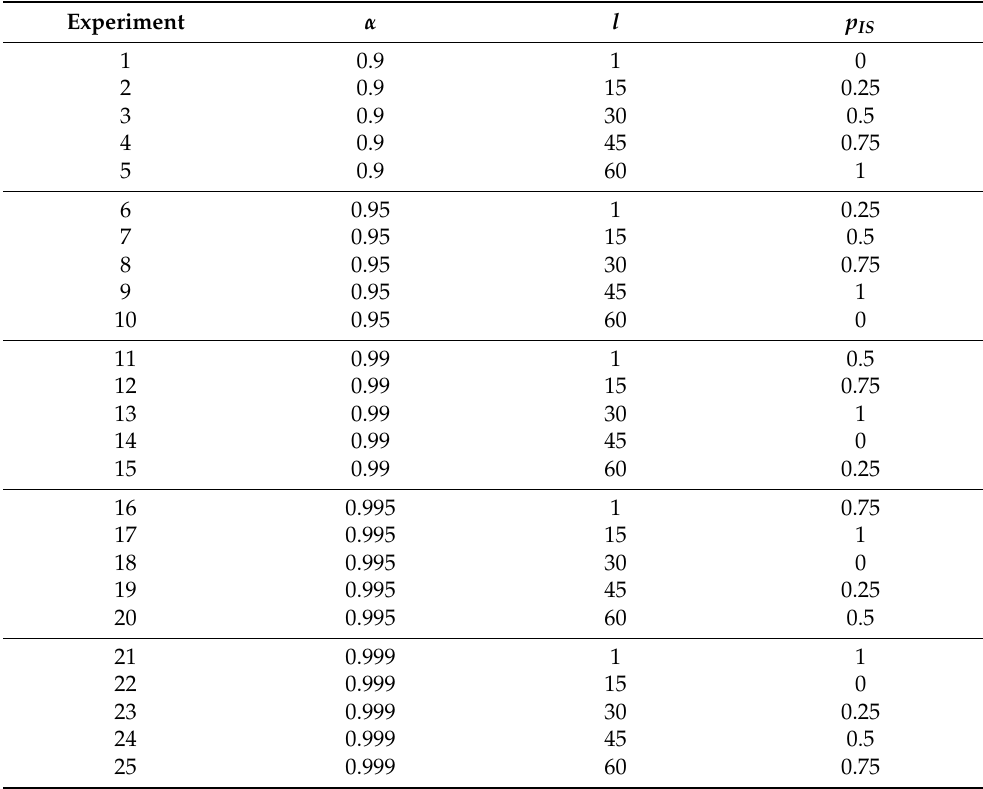
Figure 9. IG calibration. Table 7. Orthogonal array for SA